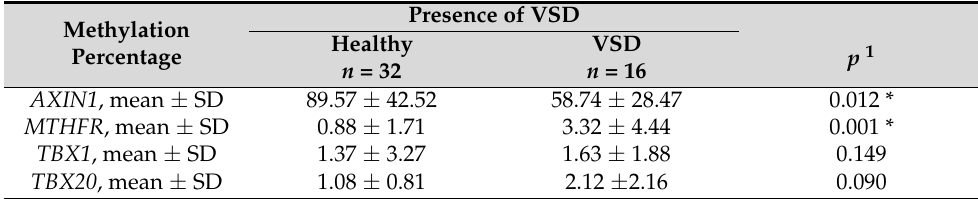
Table 4. VSD associated gene MS in all children.